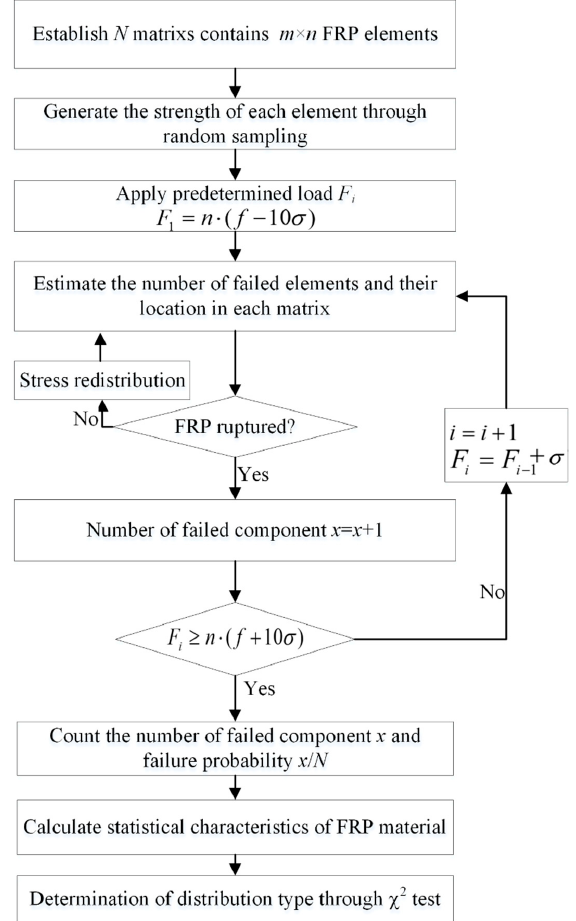
Figure 5. Flow chart of the numerical simulation process for determining the statistical characteristics ff of the CFRP strength considering the size effect. of the CFRP strength considering the size e